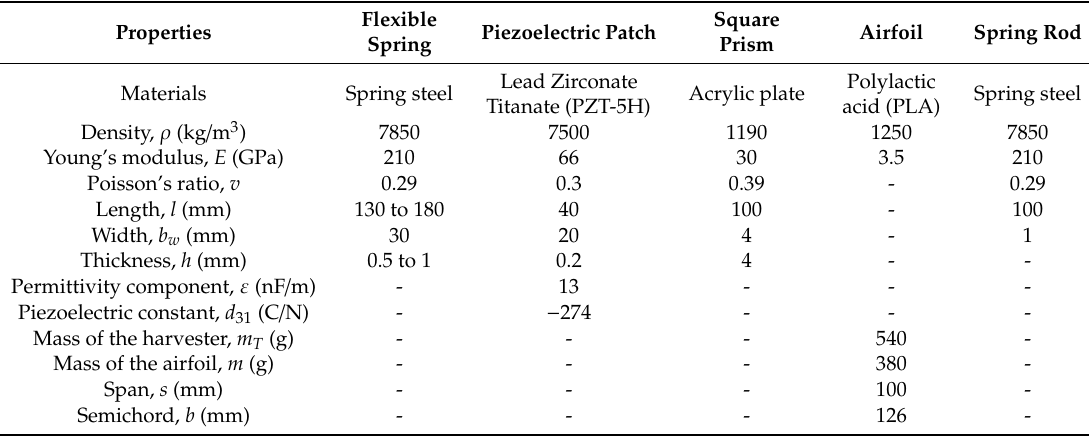
Table 1. The materials and dimensions parameters of the harvester.